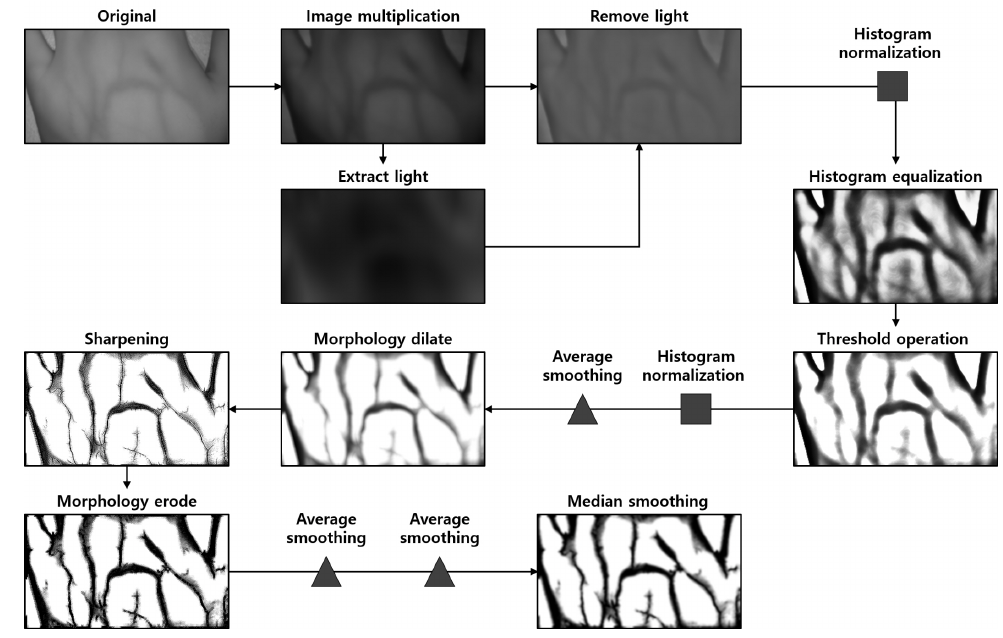
Figure 12. Vein image processing algorithm